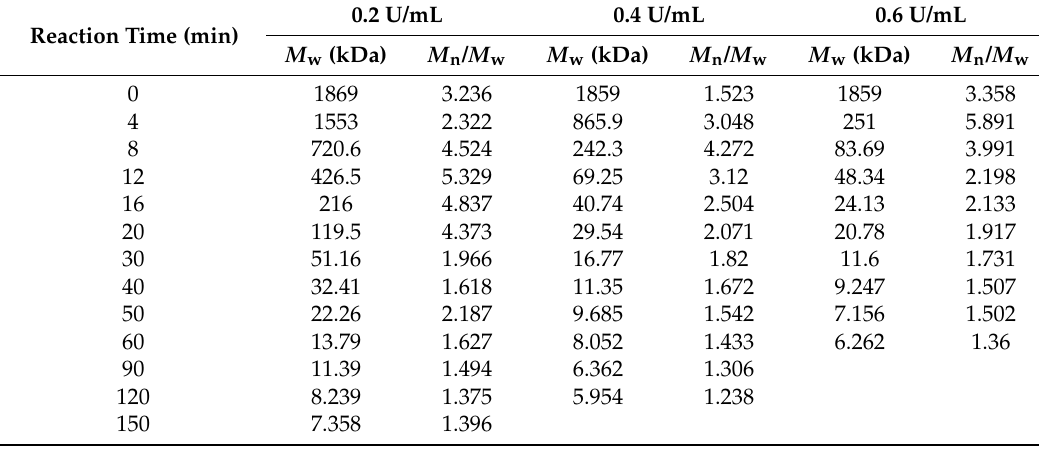
Table 6. M w and M n / M w of dextran under different dextranase activity and time. Reaction Time (min)